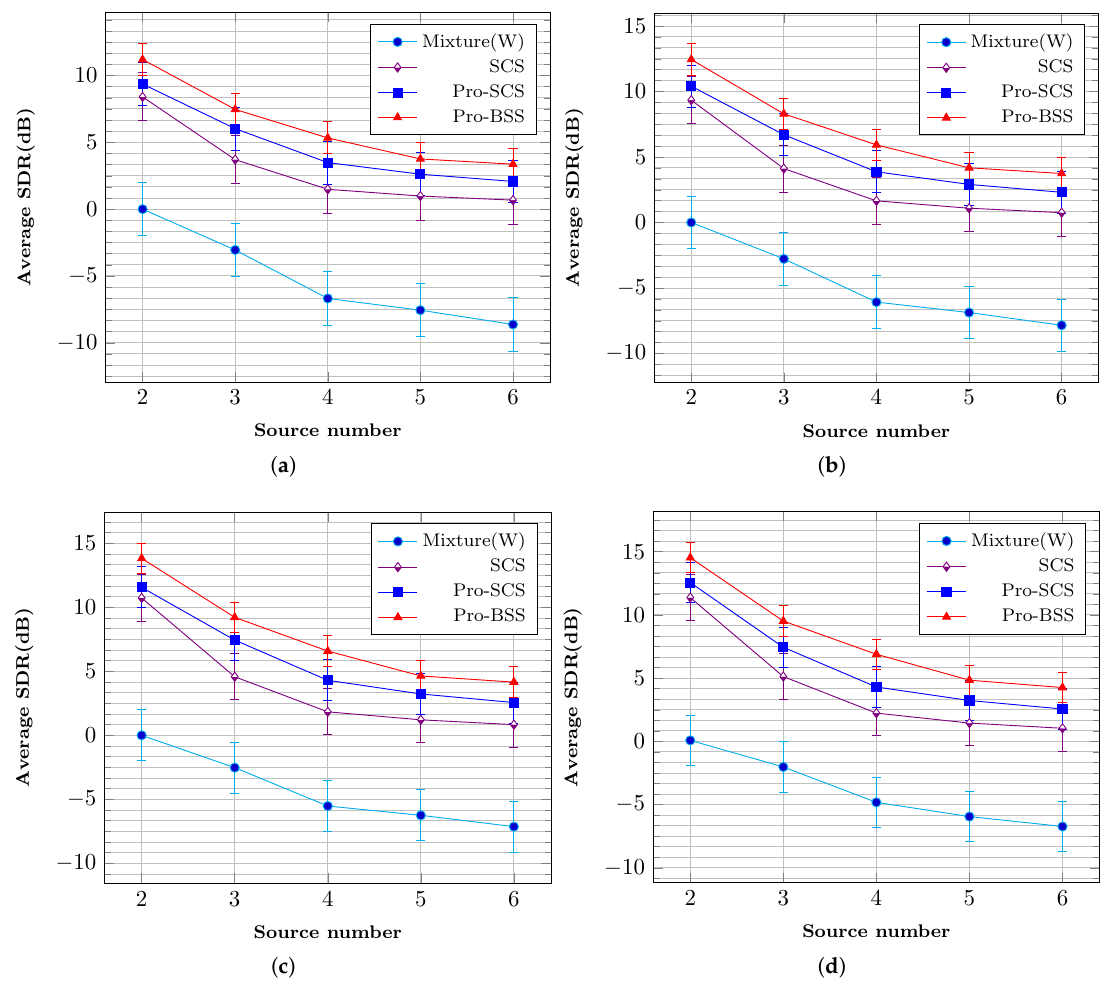
Figure 7. Signal-to-distortion ratio (SDR) results. Error bars represent 95% confidence intervals; ( a – d ) represent the results for separations {30 ◦ , 40 ◦ , 50 ◦ , 60 ◦ }. Eventually, for the determined case (i.e., K = 3), we conducted a comparison with four other existing approaches: (a) spatio-temporal ICA [32] applied using a single (recording from M i using channel W i , X i , Y i ) B-format speech mixture (S-ICA); (b) spatio-temporal ICA applied using a dual (recording from M i using channel W i , X i , Y i and corresponding channels of M j ) B-format speech mixture (D-ICA); (c) source DOA-based BSS using single coincident microphone recording (S-BSS) [28]; and DOA-based collaborative BSS (CBSS) [20] using a pair of coincident spatial microphones. Note that the reference mixture (W) is an unprocessed speech mixture (W channel of the B-format recording) used for indicating the worst quality. It should be noted that there are still many good